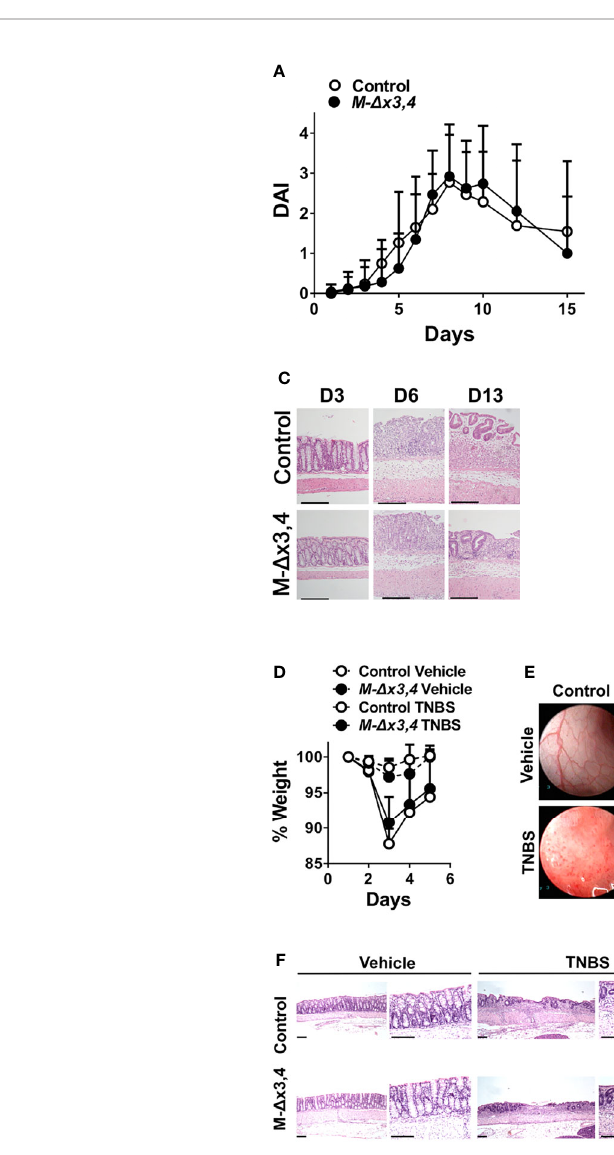
FIGURE 2 | The ablation of AUF1 functions in myeloid cells does not affect the initiation nor the progression of chemically-induced intestinal in fl ammation. (A) Macroscopic Disease Activity Index (DAI) of control and M- D x3,4 mice after treated with DSS for seven days. Line graphs depict mean values ( ± SD; n l =20-28/ group/genotype). (B) Representative photographs (left) and Scores (right) derived from the endoscopic evaluation of control and M- D x3,4 colons on the 8 th day of the DSS protocol. (C) Left. Histology of colonic tissue (left) from control and M- D x3,4 mice on days 3, 6 and 13 of the DSS protocol. Shown are representative photomicrographs of paraf fi n-embedded sections stained with H&E. Such sections were used for the evaluation of mean histological scores ( Right ) from 8-11 mice/ genotype/timepoint). (D) Whole body-weight measurements of control and M- D x3,4 mice sensitized with TNBS and challenged intrarectally either with ethanol vehicle or TNBS. Line graphs depict mean weight values ( ± SD) from n=5-9 mice/group/genotype (E) Representative photographs (left) and Scores (right) derived from the endoscopic evaluation of control and M- D x3,4 colons from mice treated with ethanol vehicle (n=5/genotype) on TNBS (n=9-10/genotype) for 3 days. (F) Left. Histology of colonic tissue (left) from control and M- D x3,4 mice on day 5 of the TNBS protocol. Shown are representative photomicrographs of paraf fi n-embedded sections stained with H&E. Such sections were used for the evaluation of mean histological scores ( Right ) from Vehicle treated (n=5/genotype), on TNBS treated (n=9-10/genotype) mice. For (B – F) , Scatter plots indicate individual and mean protein values (line). The lack of statistical signi fi cance was tested via One-Way